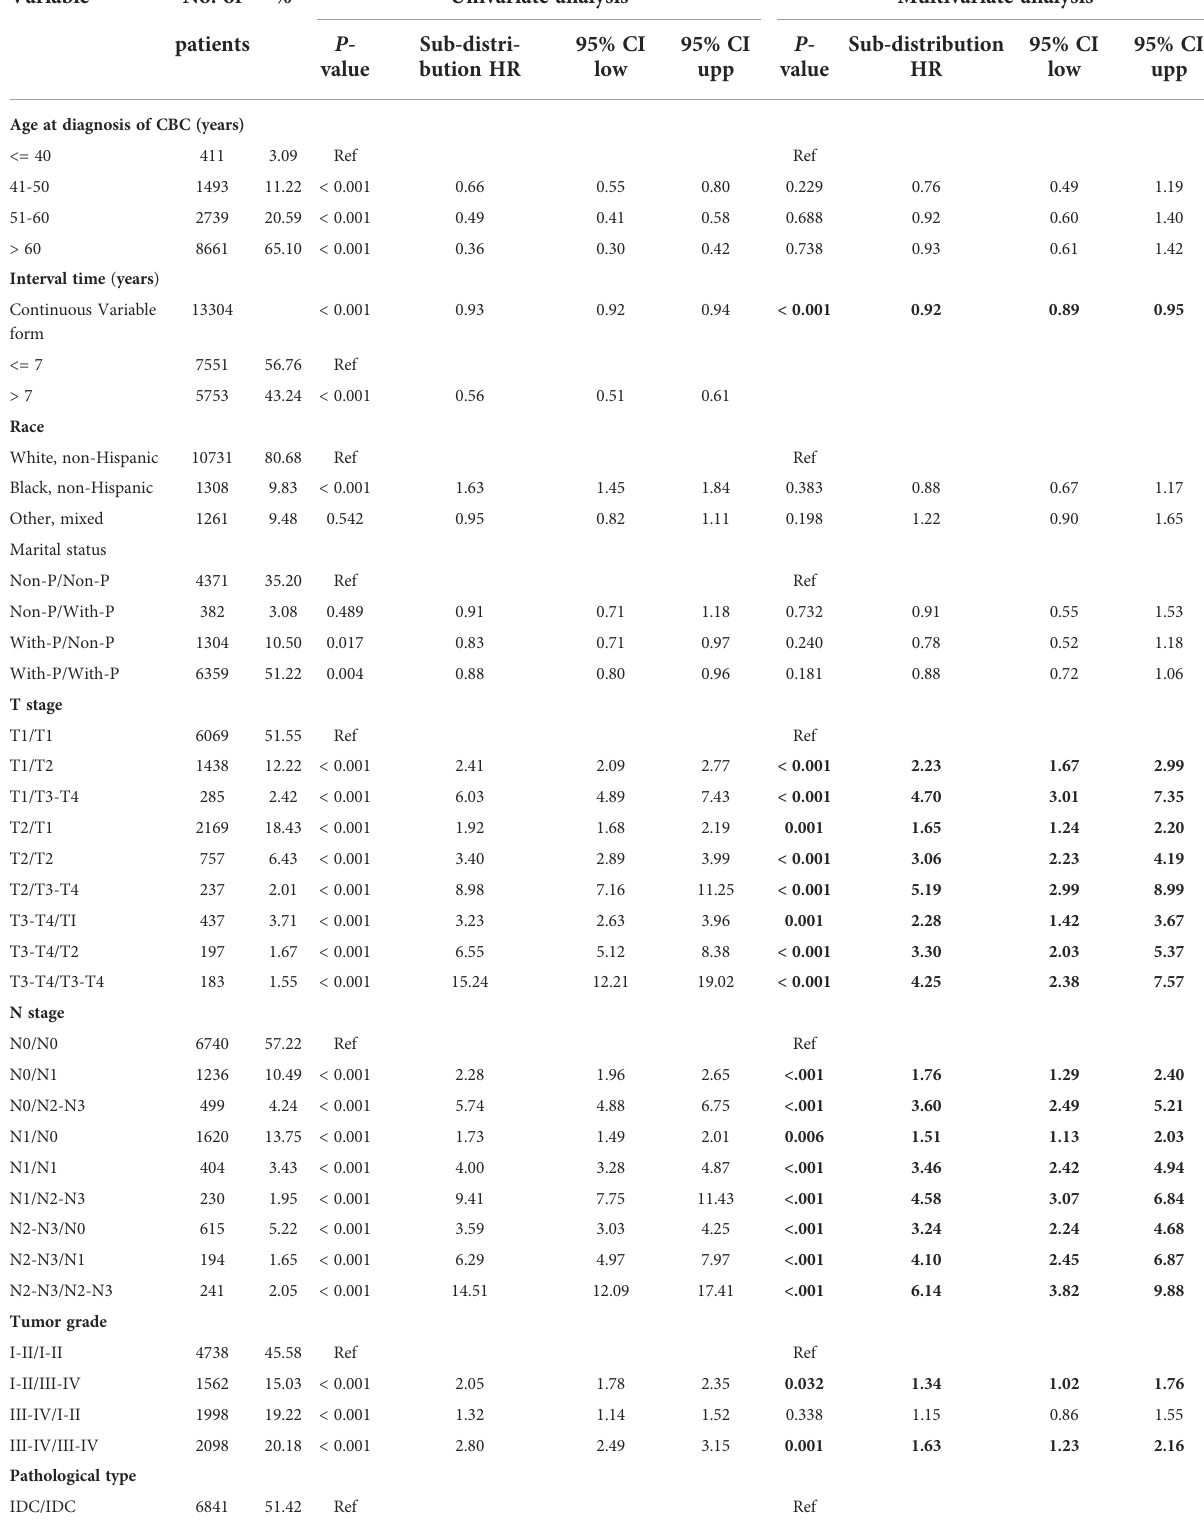
TABLE 1 Competing risk model for MBBC.